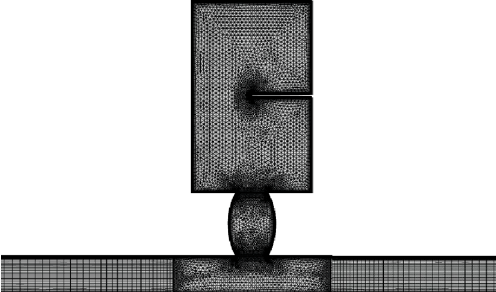
Figure 13: Mesh of the Helmholtz resonator with an arc-shaped neck and a rigid ba ffl e